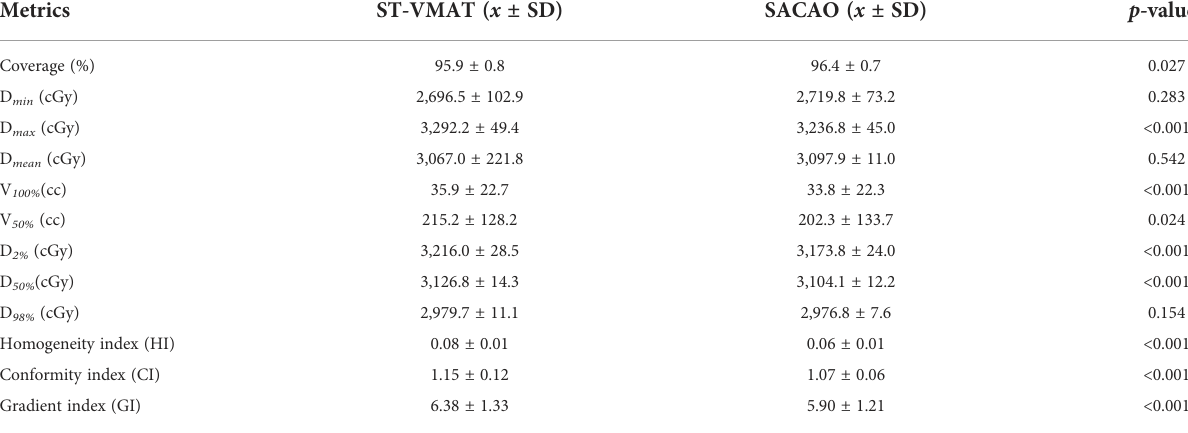
TABLE 3 Dosimetric statistics of PTV for 20 patients in terms of mean, standard deviation (SD), and related p -values.